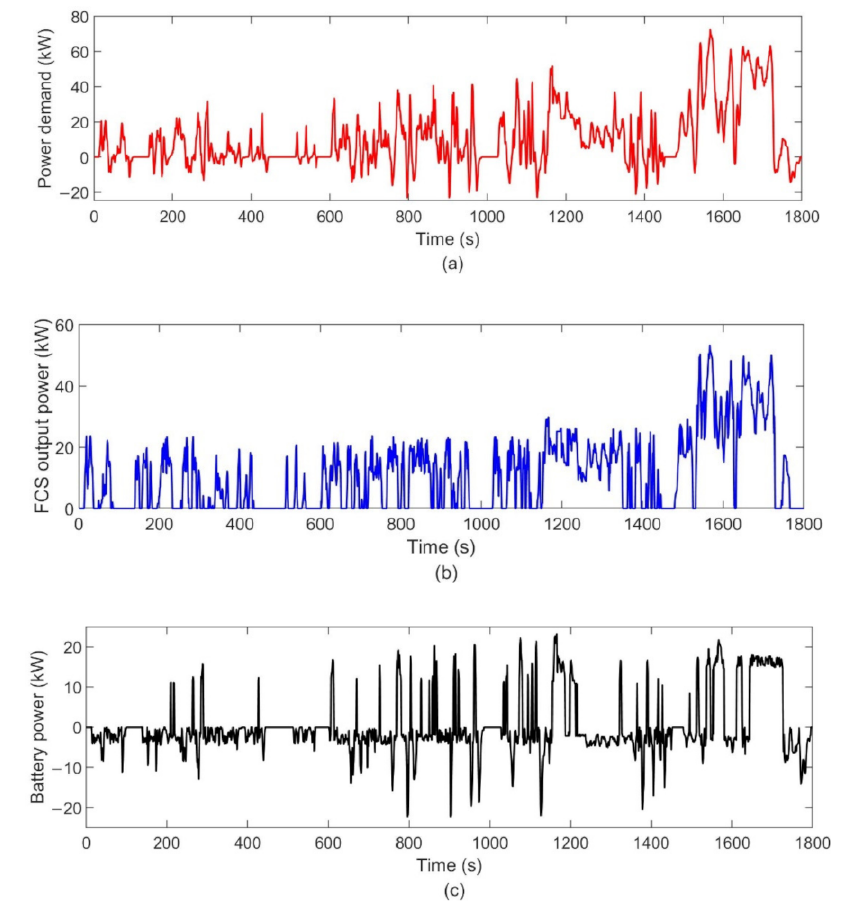
Figure 15. Power allocation with DP-based